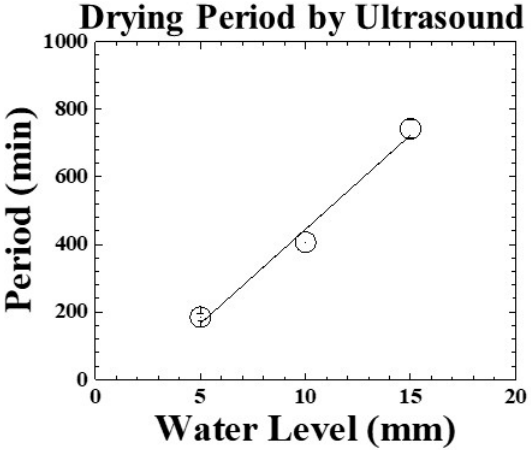
Figure 10. Drying periods measured by ultrasonic signal with respect to various water levels. Water level: 5, 10, 15 mm.